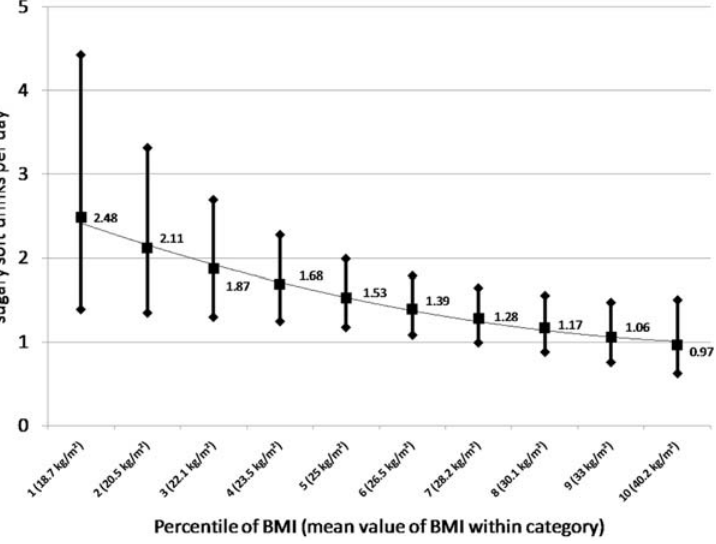
Figure 3. Adjusted Odds Ratios (aORs) comparing albuminuria among consumers of 2 + vs. 0–1 sugary soft drinks per day, according to interaction with body mass index (BMI). Adjusted for diet soda consumption, age, race, ethnicity, poverty status, BMI, and BMI- squared.